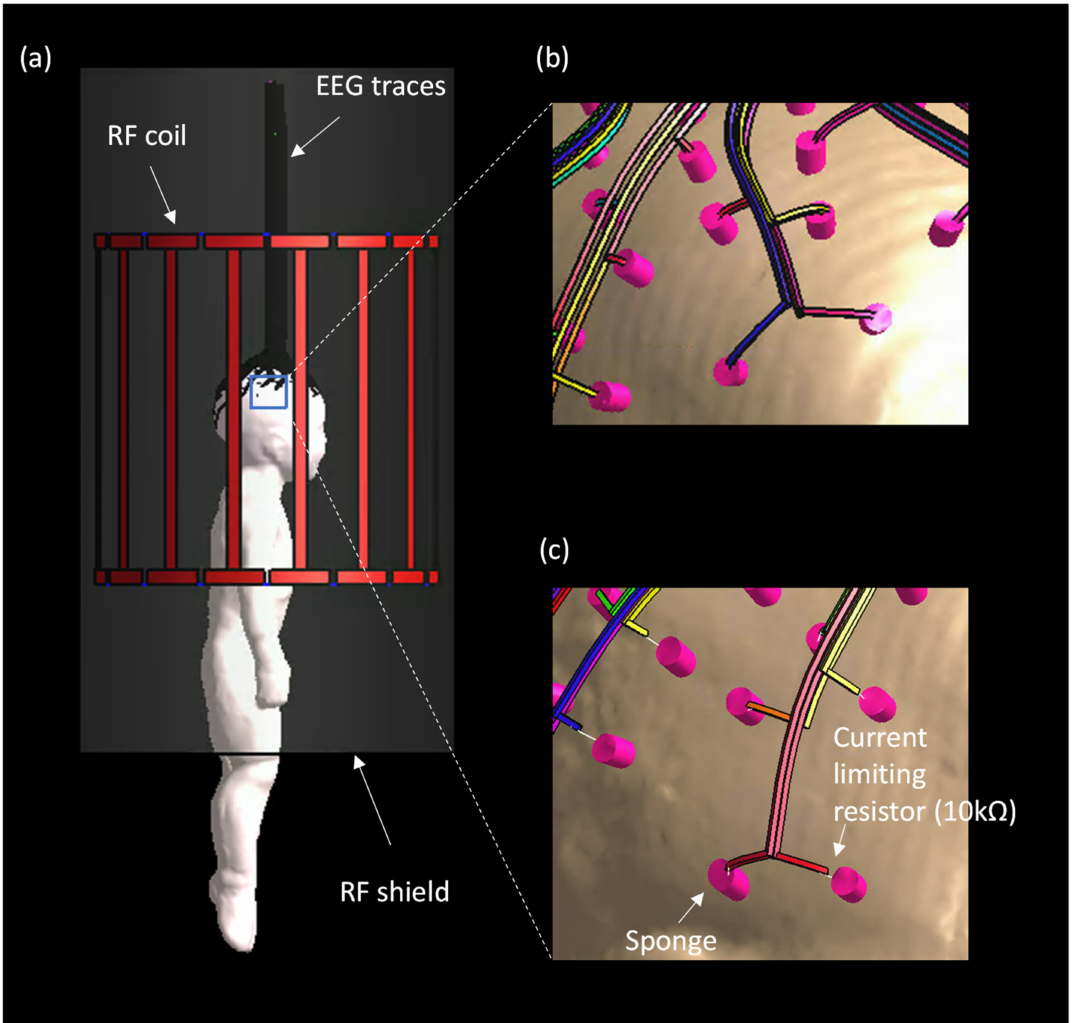
Figure 3. Geometry of the numerical simulations. ( a ) Geometry of the 29-month-old male model positioned at the center of a shielded body transmit coil wearing the NeoNet, ( b ) geometry of the EEG traces without current limiting resistors, ( c ) EEG traces with current limiting